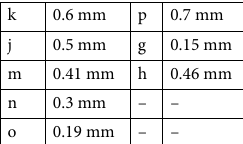
Table 2. Dimensions of the proposed 8 × 8 and 8 × 16 antenna